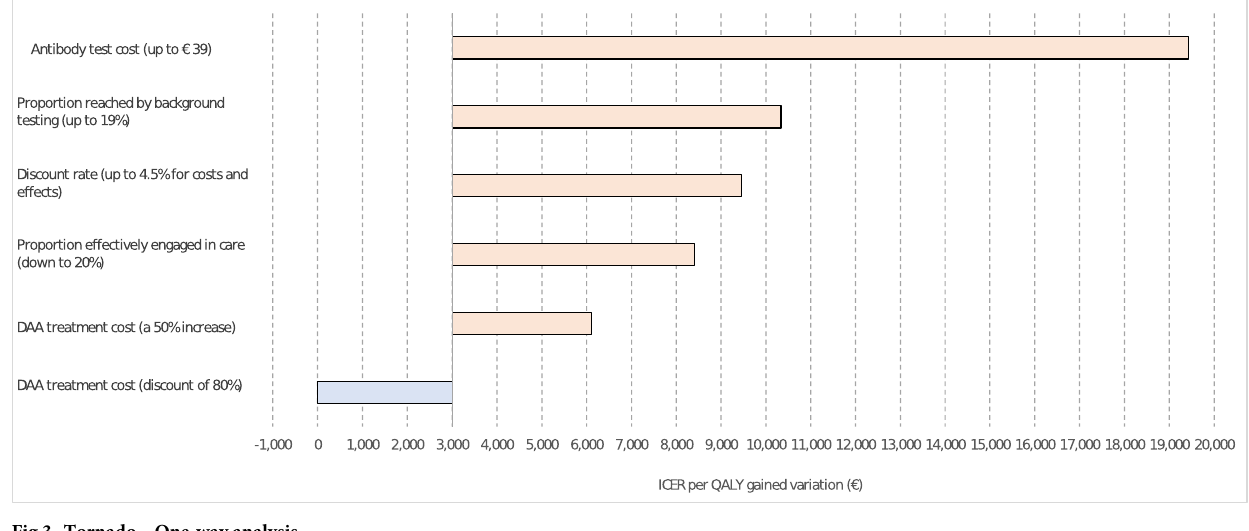
Fig 3. Tornado—One-way